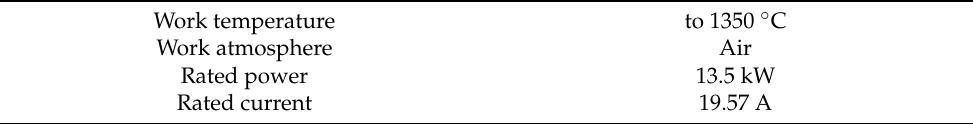
Table 3. Working parameters of a resistance pit furnace.